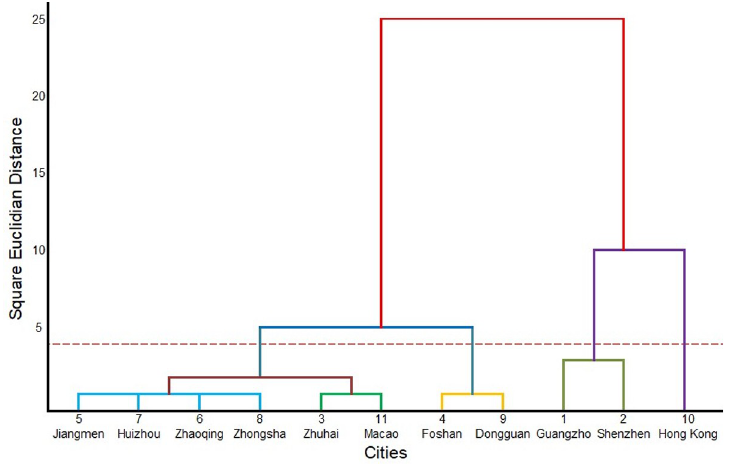
Fig 5. Tree diagram of the hierarchical clustering